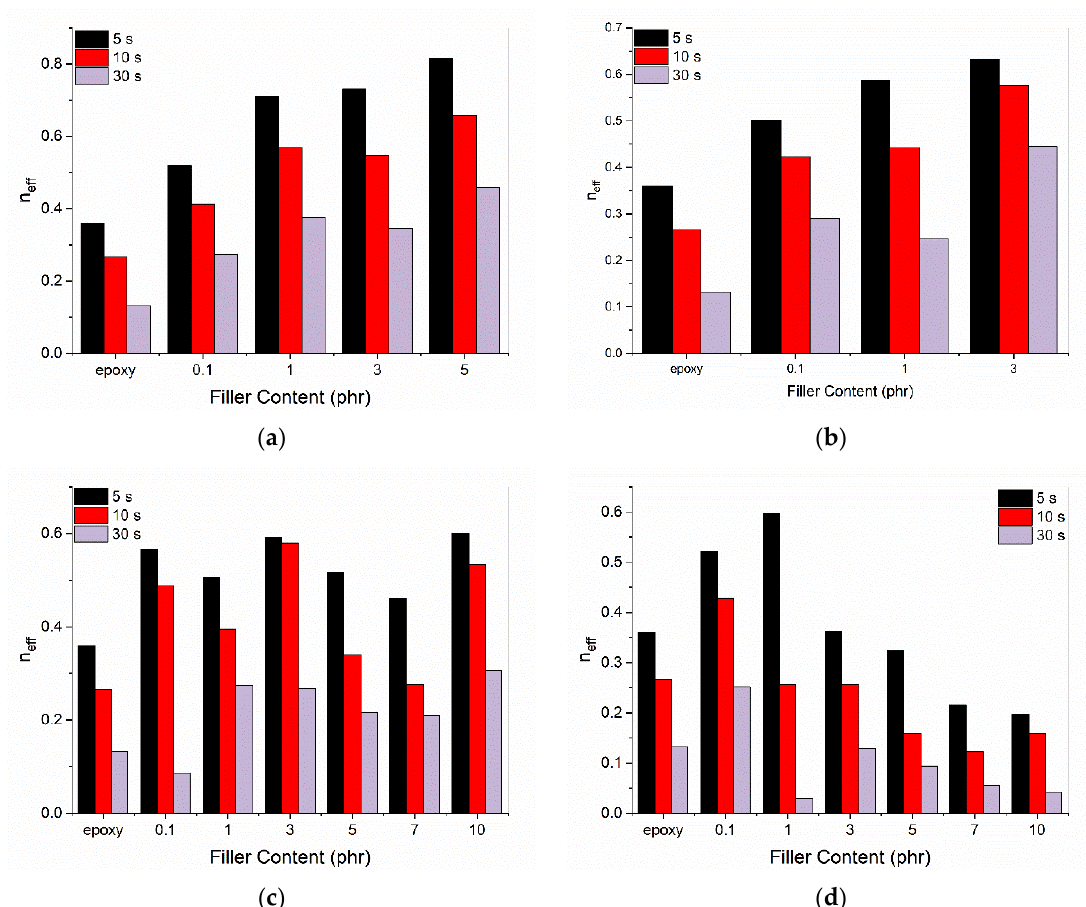
Figure 9. The coefficient of energy efficiency as a function of the filler content at the same instant times of t = 5, 10 and 30 s for the nanocomposites with ( a ) carbon black; ( b ) MWCNT; ( c ) GnP; ( d ) ND, at 100 V.